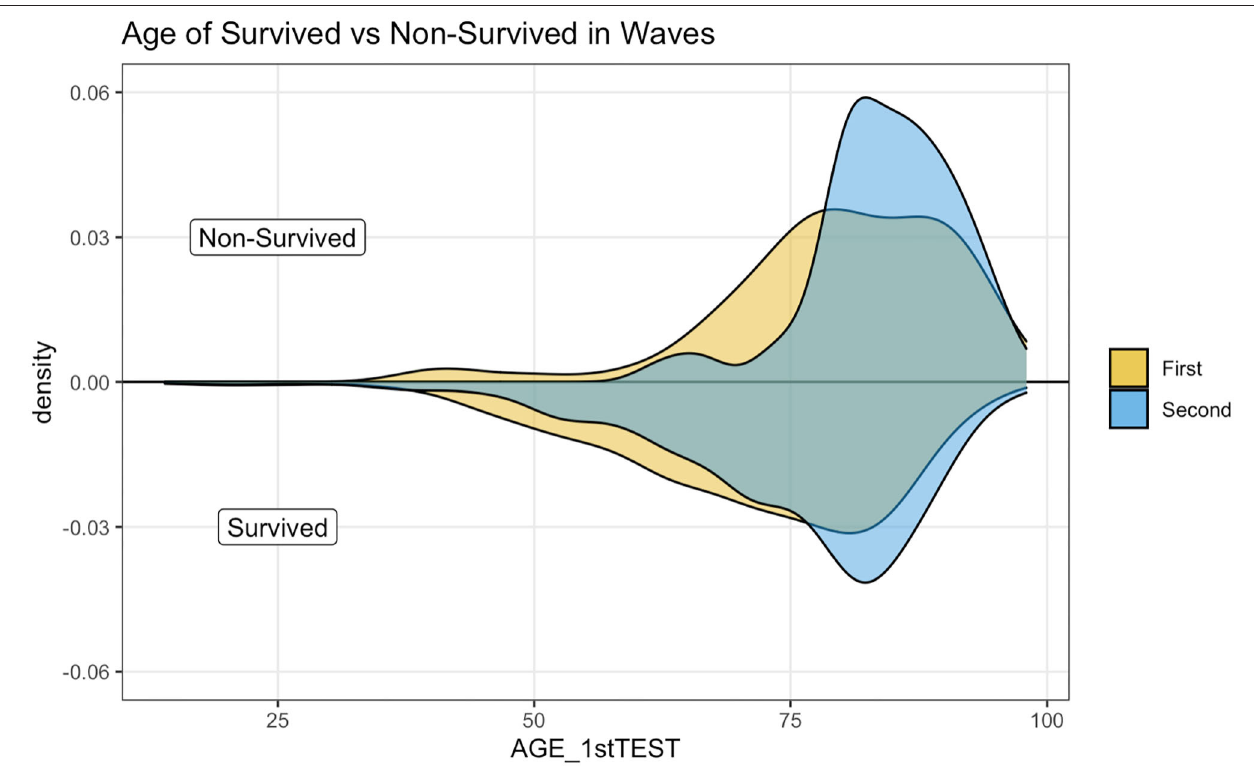
FIGURE 3 | Age distribution by wave in survived and non-survived